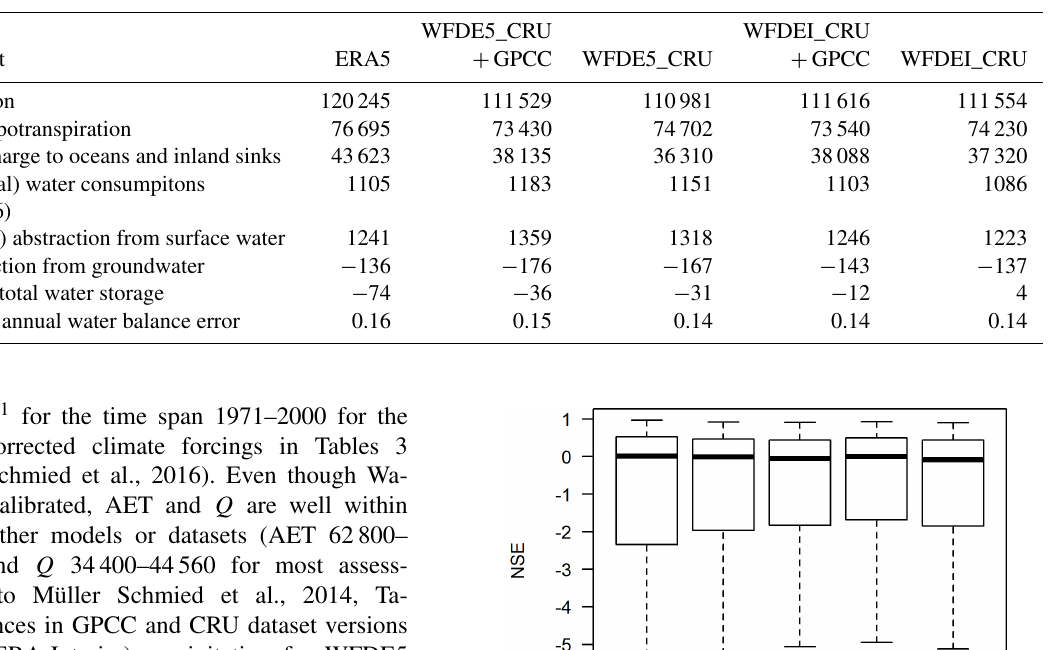
Table 5. Long-term-annual water balance components [km 3 yr − 1 ] as simulated with uncalibrated WaterGAP 2.2c for 1981–2010 and for global land area (except Antarctica and Greenland).